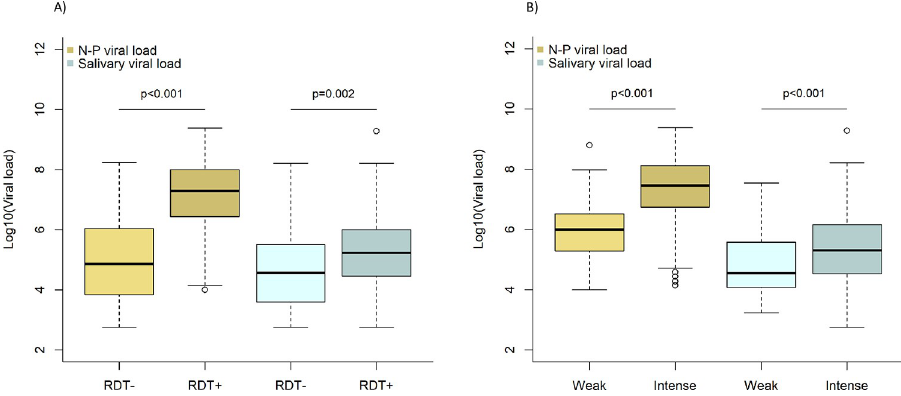
Fig 6. Log viral loads by NP PCR and saliva PCR according to A) RDT result and B) intensity band of positive